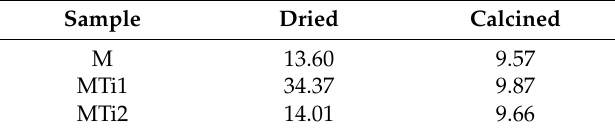
Table 3. Basal spacing (Å) for the dried and calcined samples.